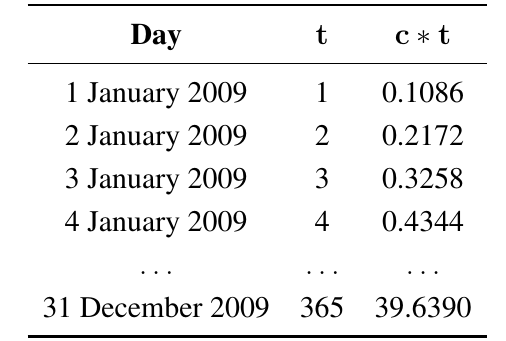
Table 1. Two choices of time values: a naive choice of t and a scaled choice of c (cid:3) t for the PM data set, where the factor c = 0 : 1086 2 : 5